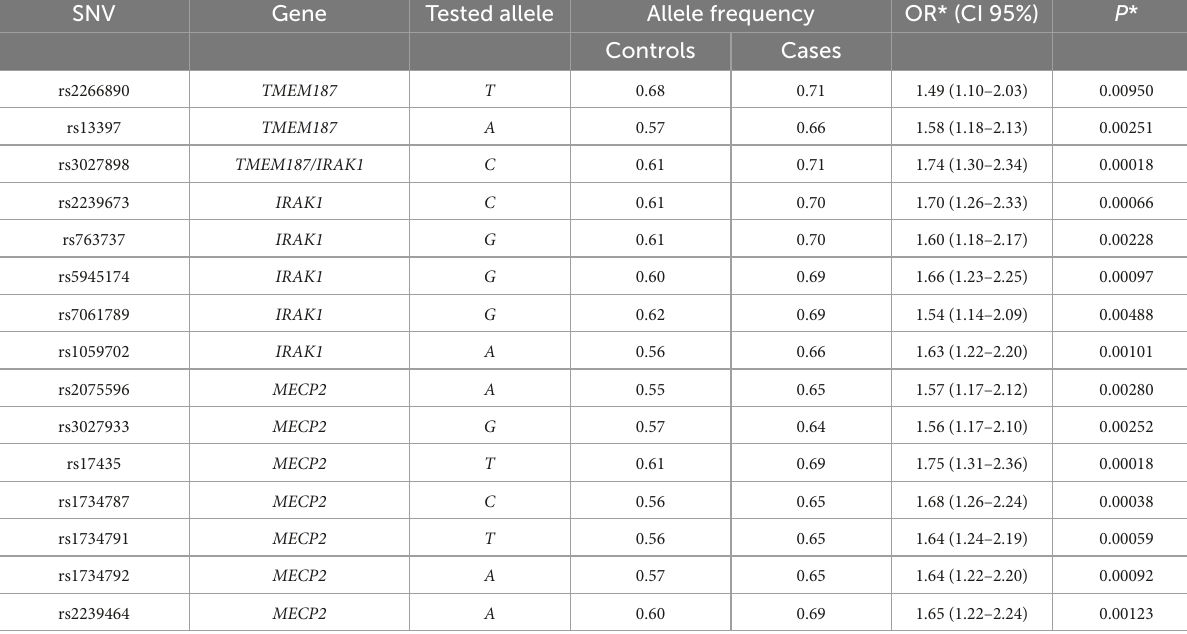
TABLE 1 Case-control allelic association.